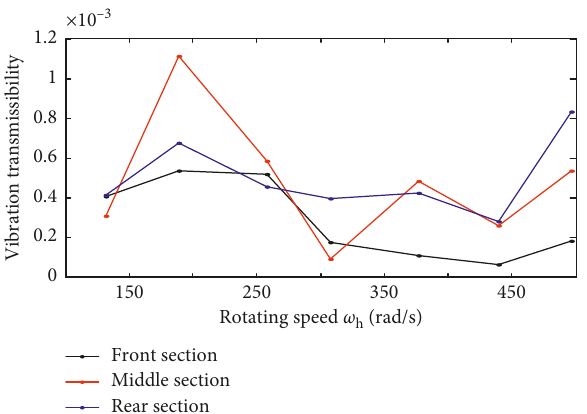
200rad/s, ω l 125rad/s. (cid:30) (cid:30)